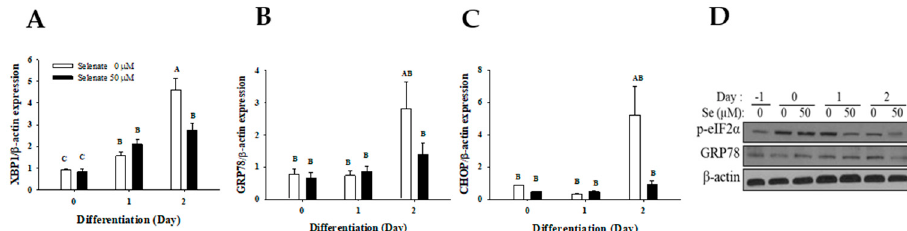
Figure 6. Selenate pretreatment inhibits endoplasmic reticulum (ER) stress marker gene expression during the early stage of adipogenesis. After 24 h pretreatment with 50 μ M selenate (Se), RNA and protein samples were collected at Day 0, 1, and 2 of differentiation. Quantitative RT-PCR was performed to measure mRNA expression of ( A ) XBP1 , ( B ) GRP78 , and ( C ) CHOP . ( D ) Protein levels of p-eIF2 α and GRP78 were assessed by immunoblot analysis. Data represents mean ± SEM ( n = 12). β -actin was an internal standard. Data represents mean ± SEM ( n = 12). Different characters indicate significant difference at p < 0.05.